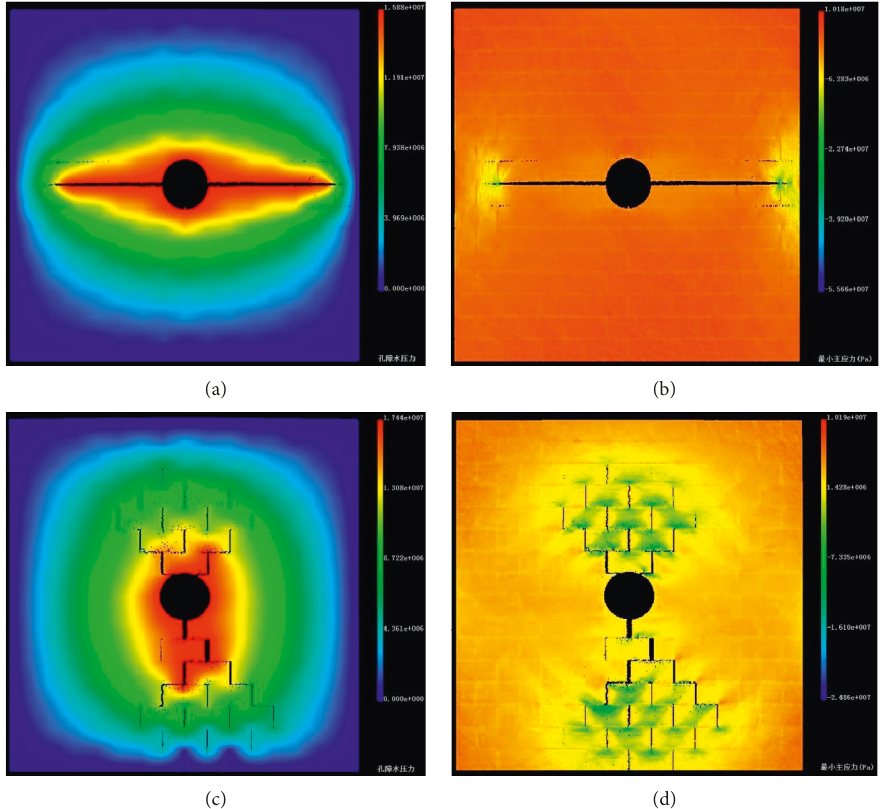
Figure 12: Pore pressure field (a, c) and minimum principal stress distribution (b, d) of masonry-shaped joint models: σ σ h � 10MPa (a, b) and σ H � 10 MPa, σ � 15MPa (c, d).